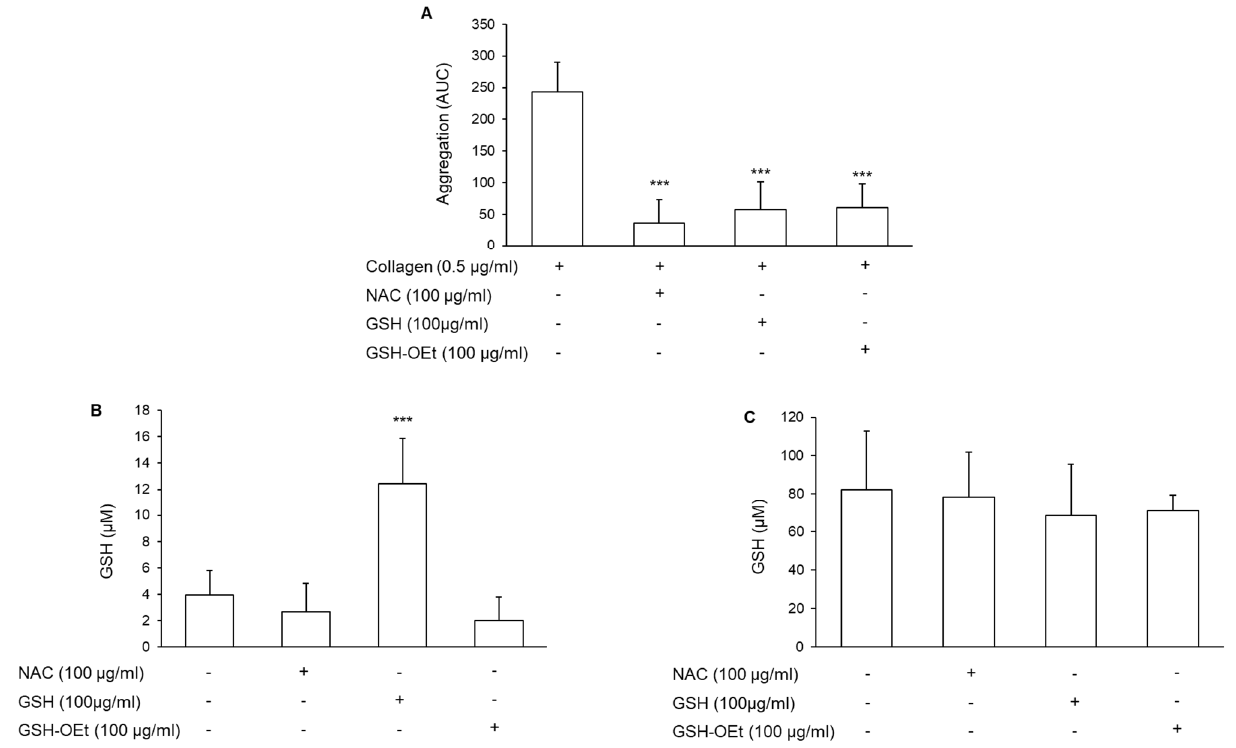
Figure 2. Effect of GSH, NAC, and GSH-OEt on platelet aggregation and on plasma and platelet GSH levels. PRP was incubated with NAC, GSH, or GSH-OEt for 30 min at 37 °C. ( A ) Platelet aggregation was induced by the addition of collagen and monitored for 6 min, n = 5. *** p < 0.001 vs. collagen-stimulated PRP. ( B ) Plasma and ( C ) intracellular GSH levels were measured by LC-MS/MS. n = 5 and n = 6 for plasma and platelet levels, respectively. *** p < 0.001 vs. basal condition for ANOVA and Dunnett’s post hoc test.